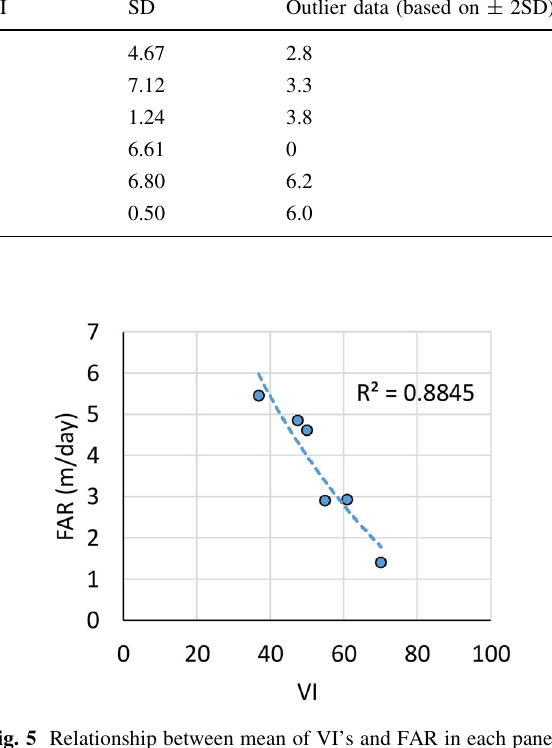
Fig. 4 Relationship between mean of VI’s and FAR in each of the gates of panels, a logarithmic regression analysis